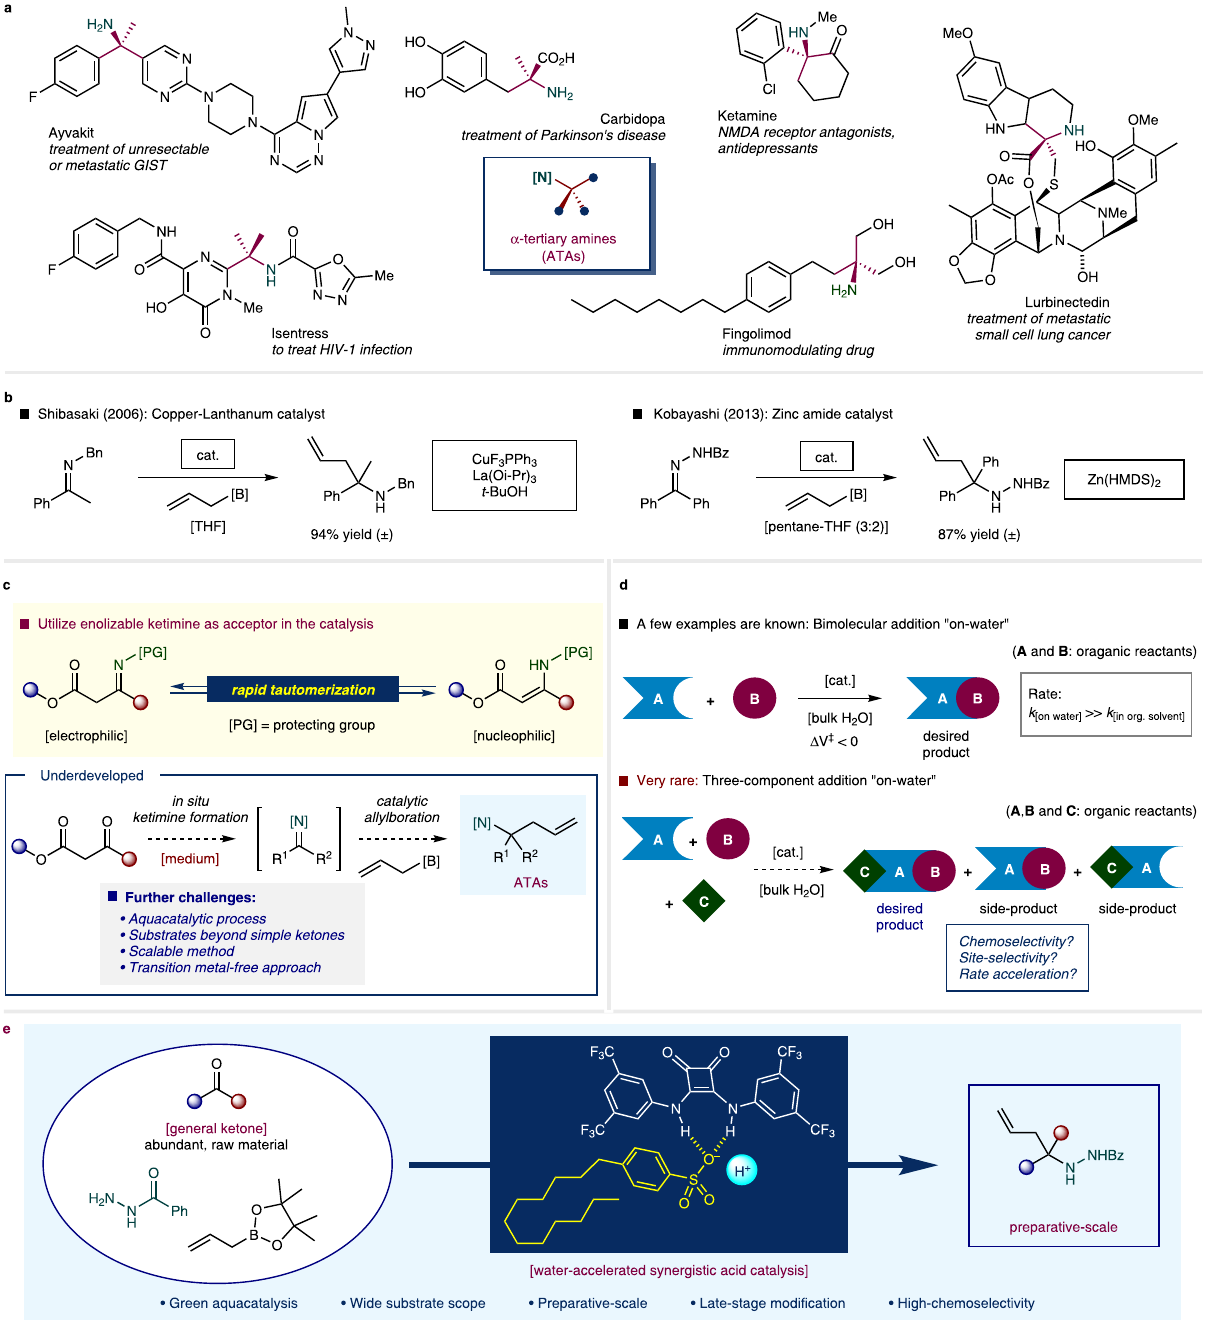
Fig. 1 Importance of the α -tertiary amine (ATA) containing molecules and the catalytic allylboration approach toward ATA. a ATA moiety incorporated pharmaceuticals. b Catalytic approaches of ATAs and allylboration toward homoallylic amine. c Challenges in the current catalytic allylboration. d Hydrophobic ampli fi cation under aquacatalytic system. e Multi-component organocatalytic allylation (this work). Ac = acetyl; Bn = benzyl; t -Bu = tert -butyl; Bz = benzoyl; cat. = catalyst; HMDS = bis(trimethylsilyl)amide; Me = methyl; Ph =